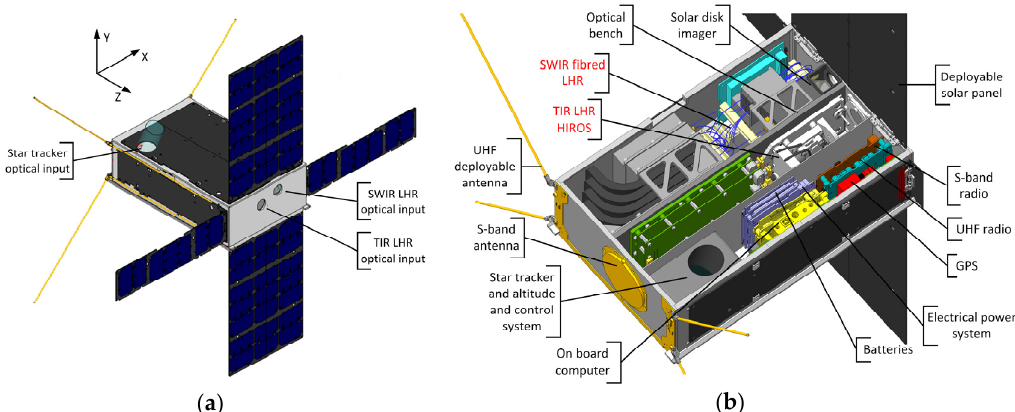
Figure 1. Three-dimensional CAD models of the MISO spacecraft: ( a ) general view of the 6U spacecraft with UHF antenna and solar panels deployed; and ( b ) configuration of spacecraft subsystems and instruments inside the spacecraft; the instruments are indicated in red.